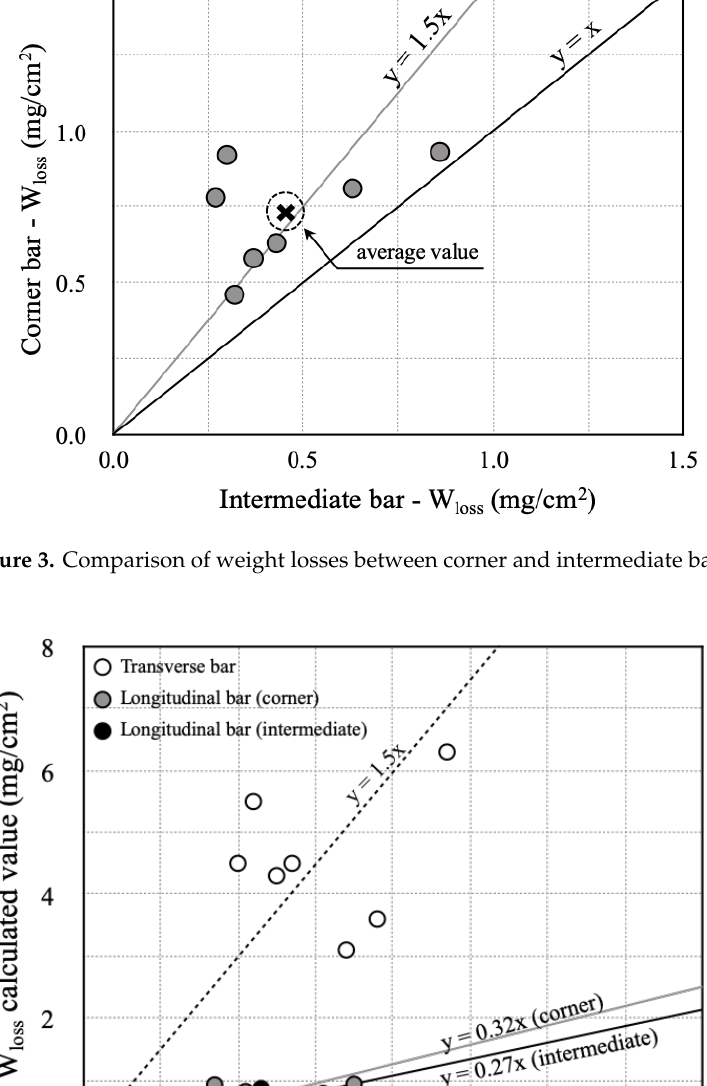
Table 4. Corrosion rate and crack width at the time of the first cracking.